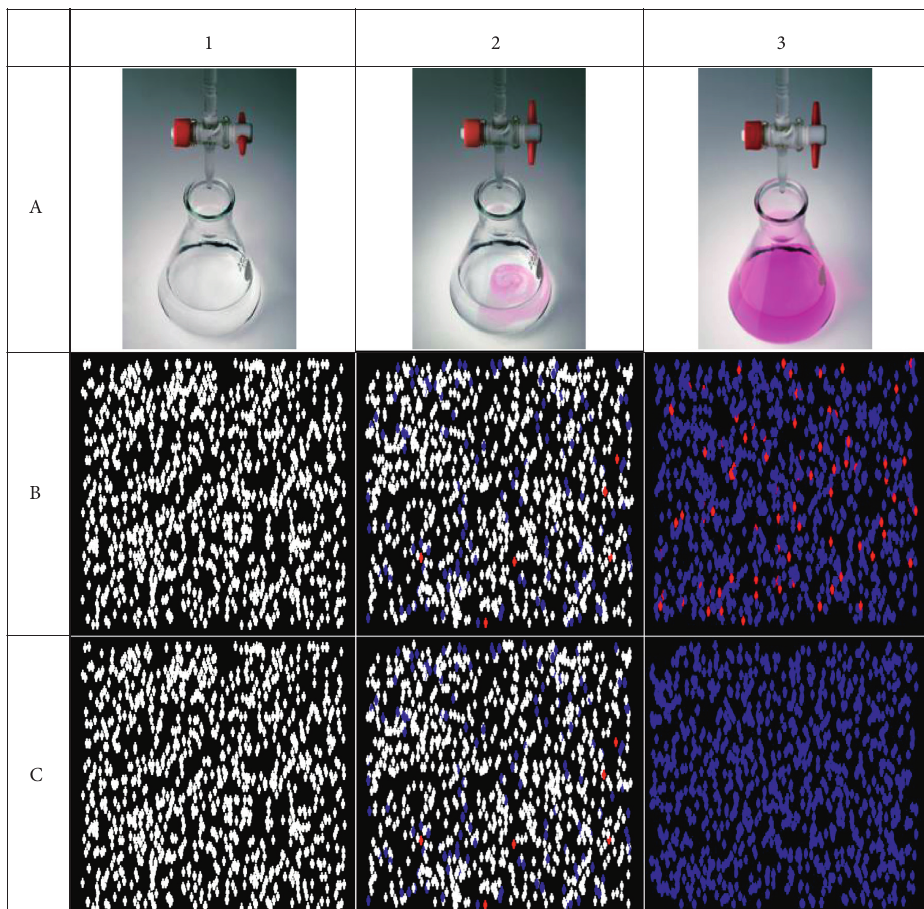
Figure 16: Three phases of acid-base indication process, dominating OAF, and nondominating OAF. (A1) Phase 1 of the acid-base indication process. (B1) Phase 1 of nondominating OAF in Bass diffusion model. (C1) Phase 1 of dominating OAF in Bass diffusion model. (A2) Phase 2 of acid-base indication process. (B2) Snapshot of phase 2 of nondominating OAF in Bass diffusion model. (C2) Snapshot of phase 2 of dominating OAF in Bass diffusion model. (A3) Phase 3 of acid-base indication process. (B3) Phase 3 of nondominating OAF in Bass diffusion model. (C3) Phase 3 of dominating OAF in Bass diffusion